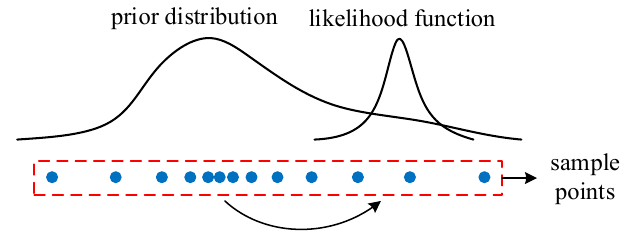
Figure 8. Transfer of sample